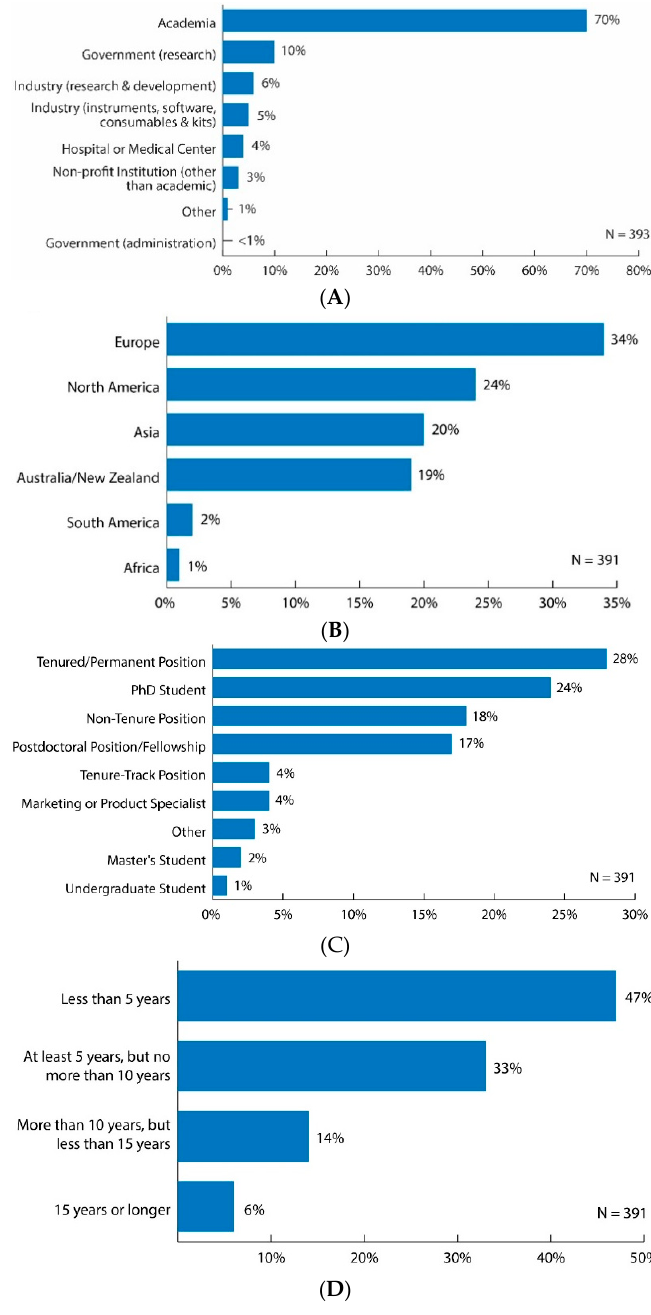
Figure 1. ( A ) Bar graph of survey results for question: “In what type of institution do you work?” Original data used to create the figure can be found in the supplementary information under